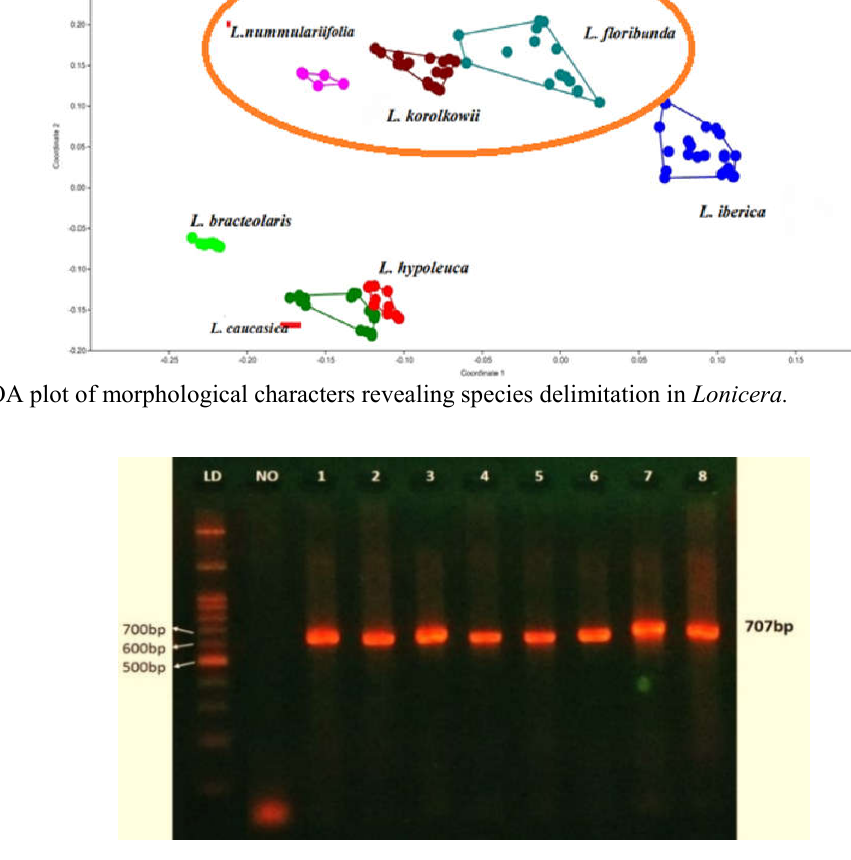
Fig. 3. Results of amplification with primer ITS on agarose 1.8% with 7 lanes gel tray. 1-8 individuals of